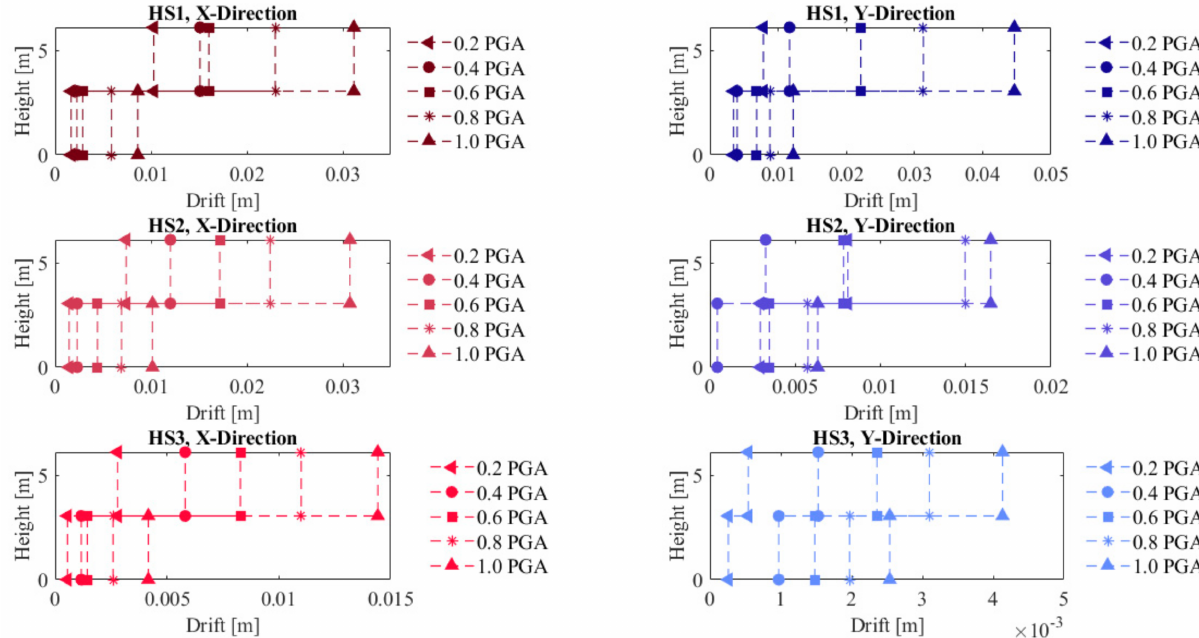
Figure 17. Storey drifts under different earthquake multiplication factors for the two main directions, at varying floor